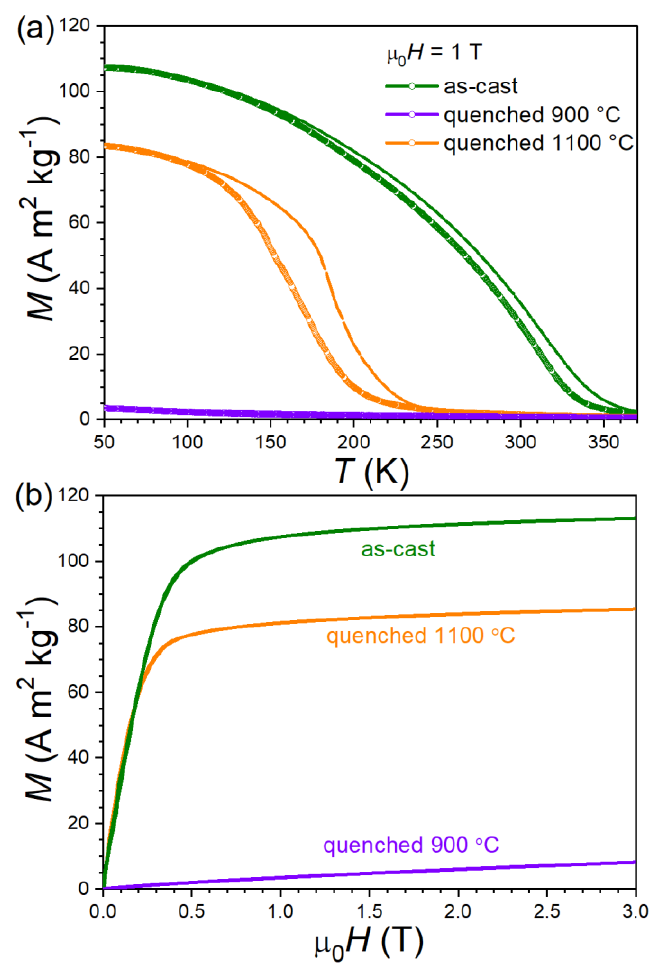
Figure 6. Magnetization of MnFe 0.53 Ni 0.47 Si 0.94 Al 0.06 synthesized using different conditions: ( a ) as a function of temperature upon heating (line) and cooling (symbols); ( b ) isothermal magnetization curves recorded at T = 50 K.